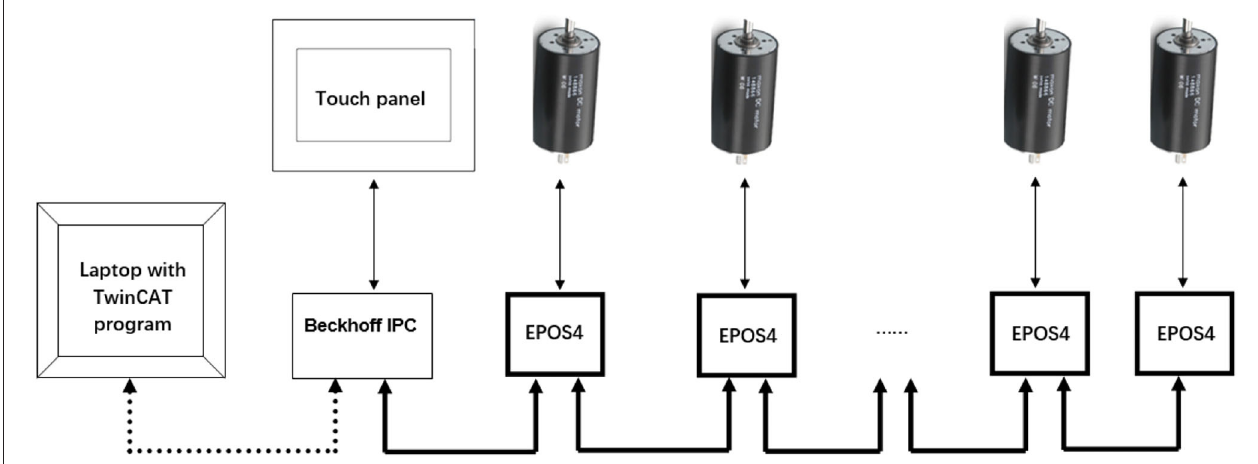
FIGURE 2 | The communication structure. The Laptop downloads the program to the Beckhoff IPC. The system can be operated using the touch panel. The IPC controls the 10 servocontrollers for the upper and lower limbs in real time (Six EPOS4 servocontrollers and their corresponding drives are omitted in the diagram).